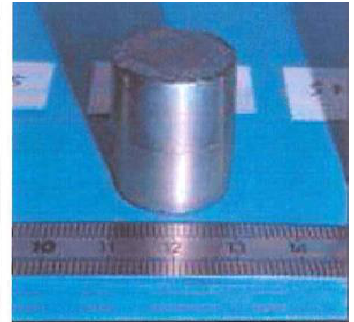
Figure 9. Example of a block joined using SPS.